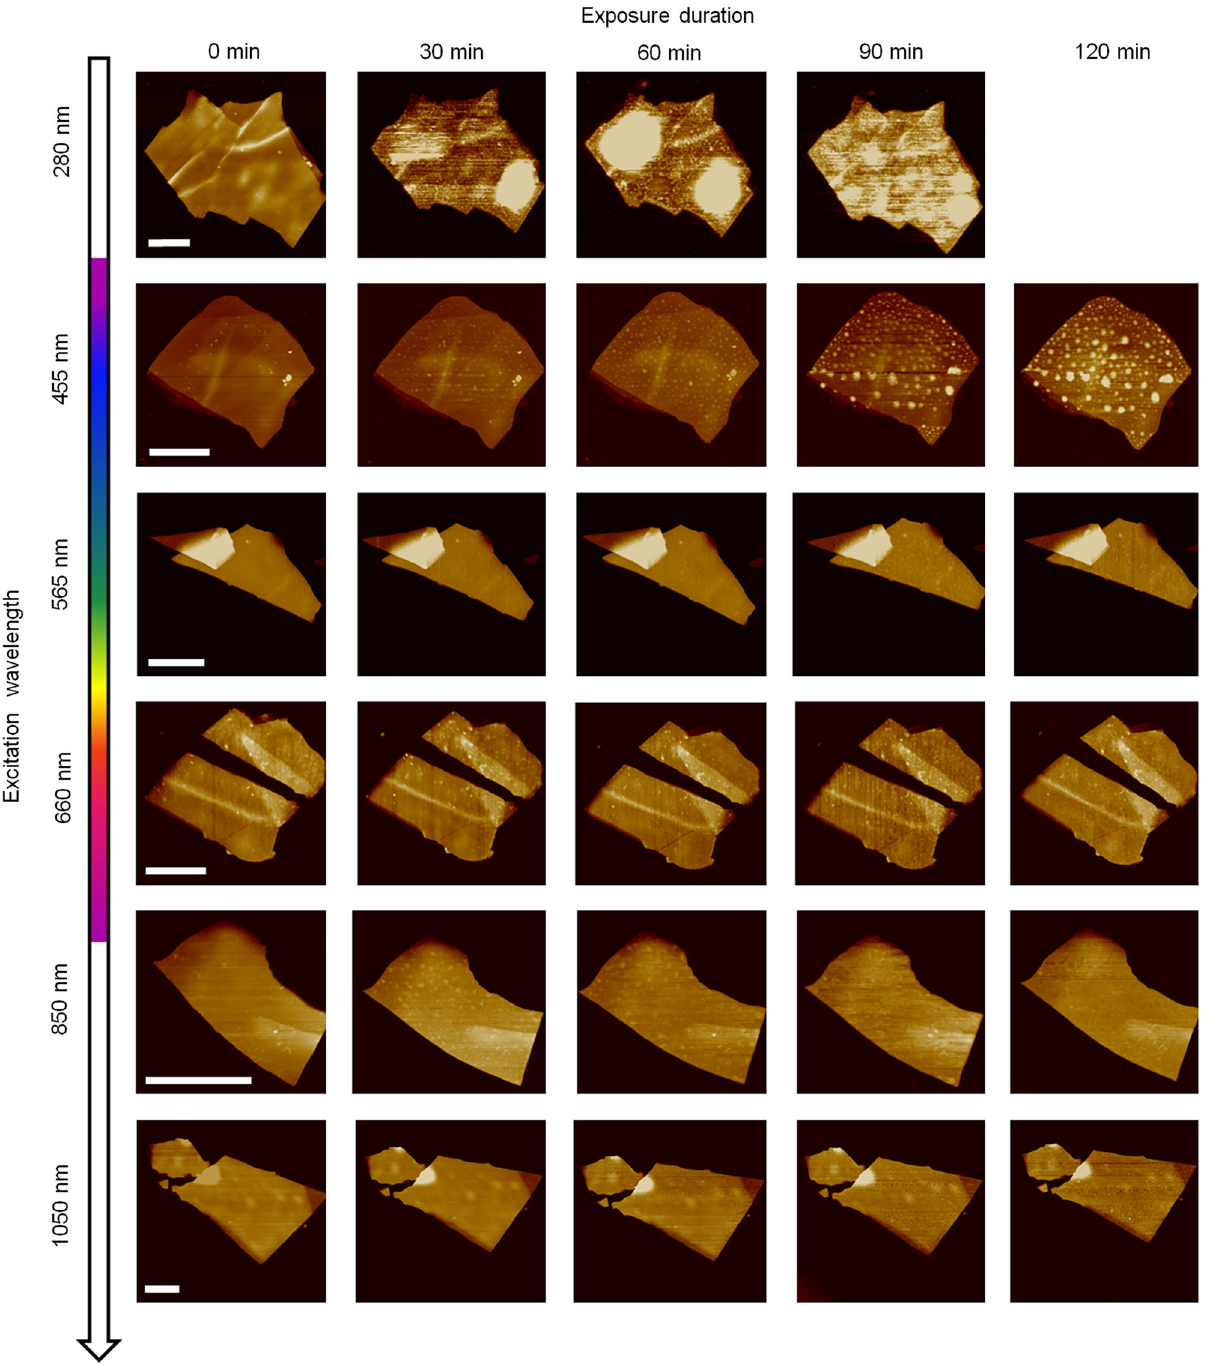
Fig. 2 Atomic force micrographs of BP fl akes showing degradation with respect to time, upon exposure to different optical wavelengths. It can be seen that the UV light causes maximum degradation followed by blue light. The degradation is observed by the appearance of bubble- like morphological features on the surface of the fl akes. Scalebars denote 1 UV, the degradation should occur regardless of subsequent the rapid degradation of BP in comparison to the rest of the light isolation from ambient environment. To verify this, we expose a spectrum. This observation is well in alignment with the AFM fresh set of mechanically exfoliated BP fl akes to UV and blue light analysis (Fig. 2) which suggests UV light to be the predominant (characterised using AFM prior to exposure, Fig. 4a) for a short contributor towards the photo-induced degradation of BP with duration of 10 min. Subsequently, the fl akes are stored in a some contribution from blue light. The aforementioned experiments demonstrated that the damaging ROS species are formed within a few minutes of photoexcitation. Hence, we hypothesise that upon exposure to ensure its comparison with the light-exposed BP fl akes. Figure 4a